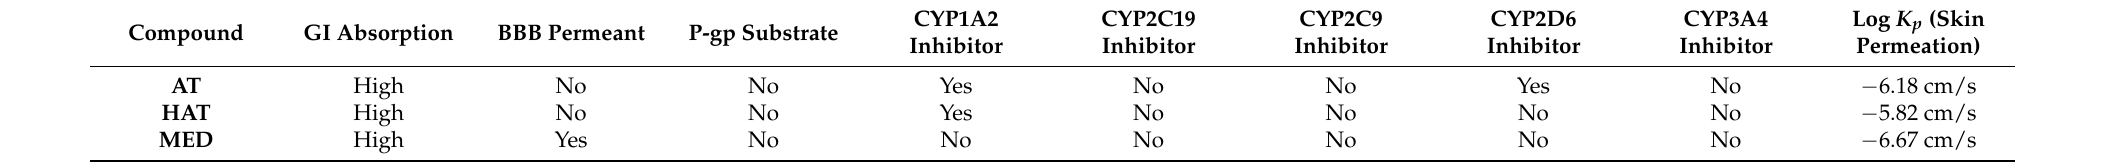
Table 5. Pharmacokinetic properties of the compounds predicted by in silico method.